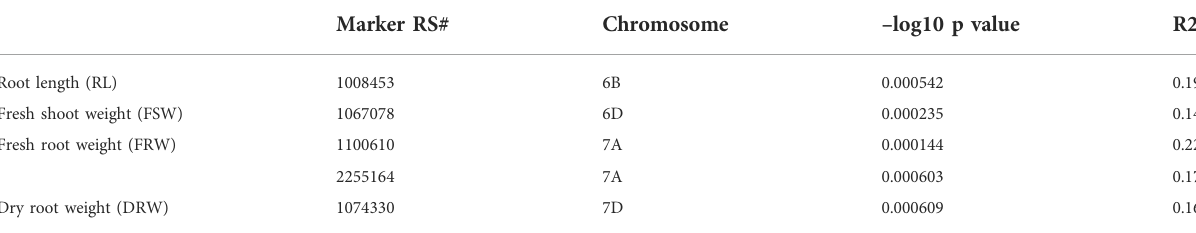
TABLE 3 Five trait loci signi fi cantly associated with salt-related seedling traits.